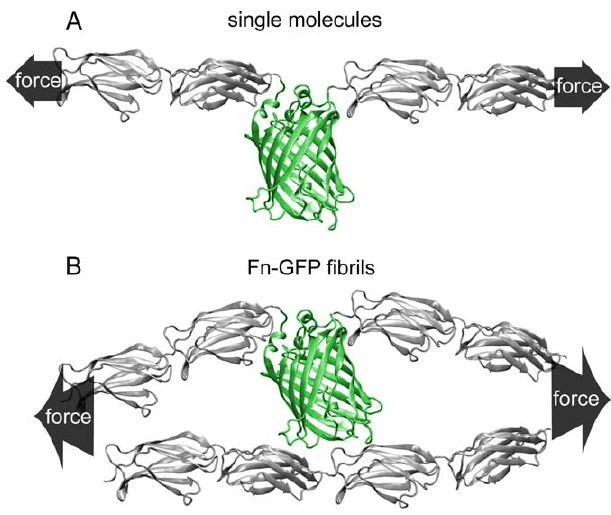
Figure 7. Restricting GFP Movement if Embedded in a Fn Fibris Cartoons of FnIII modules (gray) and GFP (green) were generated to scale using Tachyon renderer and implemented in VMD version 8.5 to illustrate the degree of protrusion from the central axis of an extended Fn-GFP molecule. In single-molecule pulling experiments, GFP has the freedom to align along the direction of force (A). If embedded into a densely packed Fn fiber that is stretched by mechanical force, the rotational motion of GFP is restricted (B), which could lead to unfolding along a different